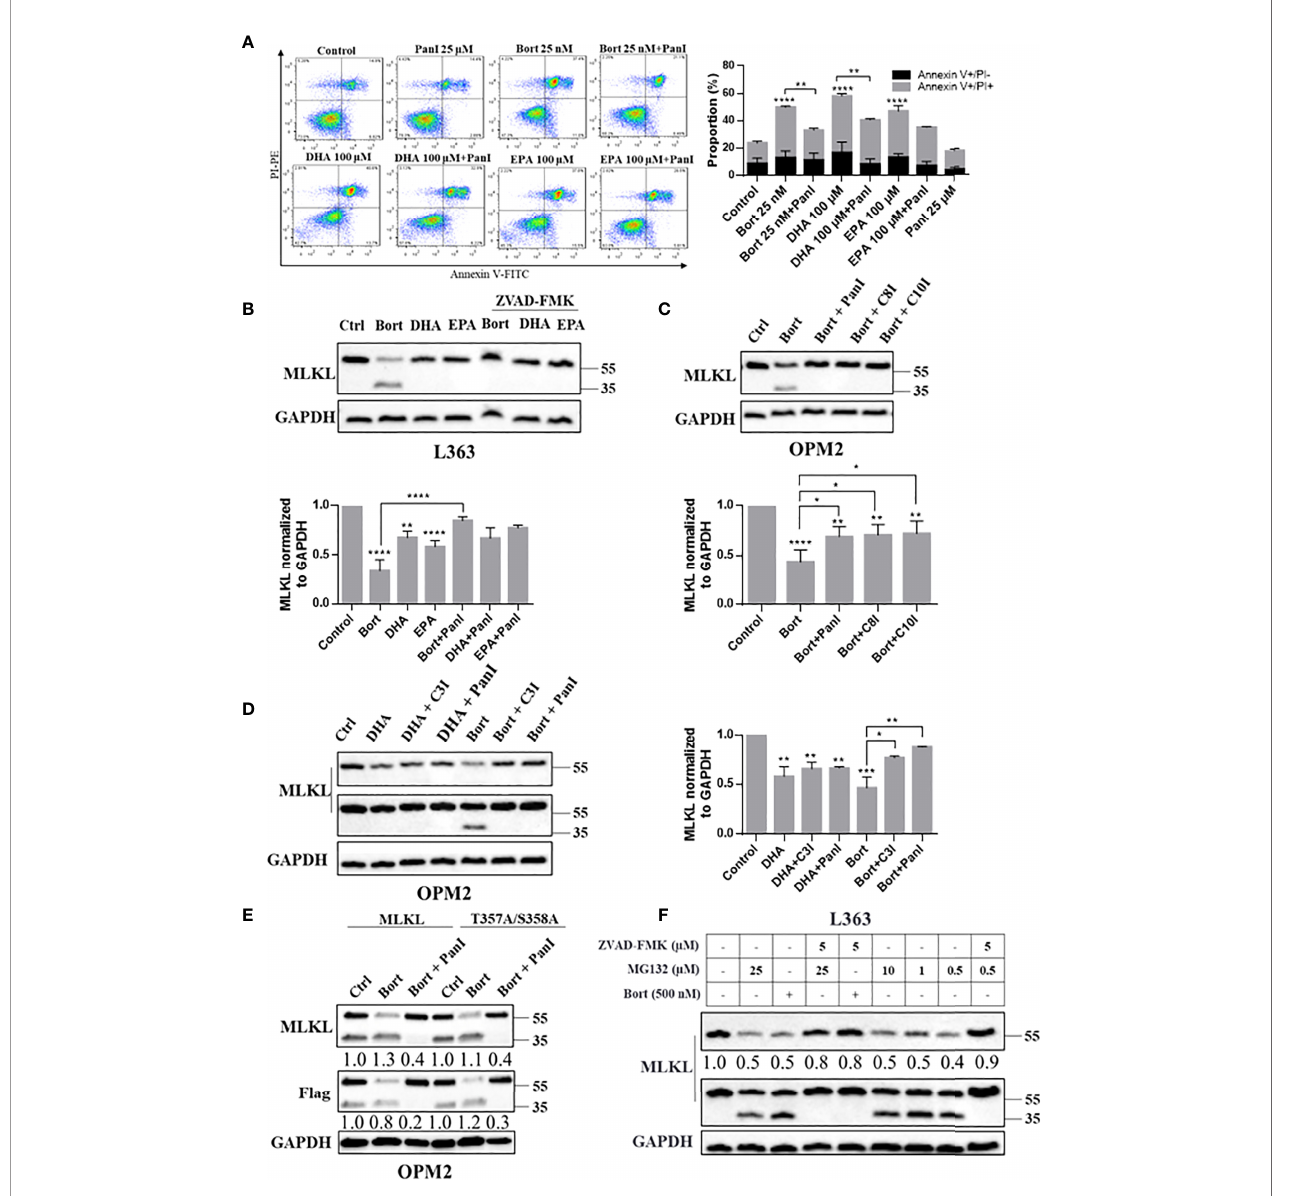
FIGURE 4 | Caspase-3/8/10 cleave MLKL in MM cells after cell death induction. (A) OPM2 cells were preincubated with or without Pan-caspase inhibitor ZVAD- FMK (20 µM) for 1 h and were then treated with bortezomib (25 nM) or DHA/EPA (50 µM) for 24 h. Cell death was determined by Annexin V and PI staining. (B) L363 cells were preincubated with or without pan-caspase inhibitor ZVAD-FMK (5 µM) for 1 h and were then treated with the indicated compounds for 24 h. (C) OPM2 cells were preincubated with or without indicated caspase inhibitors ZVAD-FMK, ZIETD-FMK, ZAEVD-FMK (D) or Z-DEVD-FMK (5 µM) for 1 h and were then treated with bortezomib (50 nM) or DHA (50 µM) for 24 h. (E) OPM2 cells were transfected with 5 µg of vectors encoding C-terminal Flag-MLKL WT or C- terminal Flag-MLKL T357A/S358A . After 18 h, transfected cells were pretreated with or without ZVAD-FMK (5 µM) for 1 h before treatment with bortezomib (50 nM) for 24 h. (F) L363 cells were treated with 500 nM of bortezomib or indicated concentrations of MG132 for 24 h in the absent or present of 1 h preincubation with ZVAD-FMK (5 µM). After treatments, whole cell lysates were immunoblotted with indicated antibodies. Data were expressed as mean ± SD of. * p < 0.05, * * p < 0.01, *** p < 0.001, **** p <0.0001 when compared to control. The fold changes of C-MLKL, C-Flag or total MLKL in the respective lanes in (E, F) were normalized to GAPDH and quanti fi cation numbers are presented in the bottom of corresponding